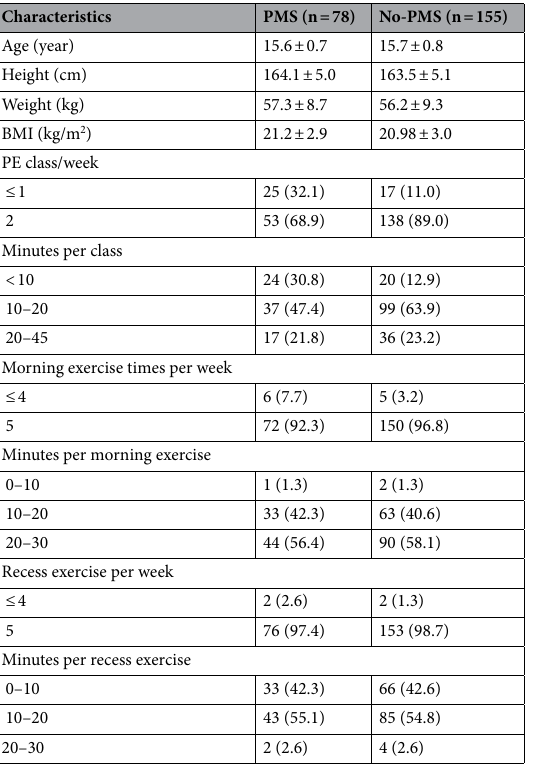
Table 1. General information for female students of senior high school. Data are presented as number (percentage) or mean ± SD. BMI body mass index, PMS premenstrual syndrome.